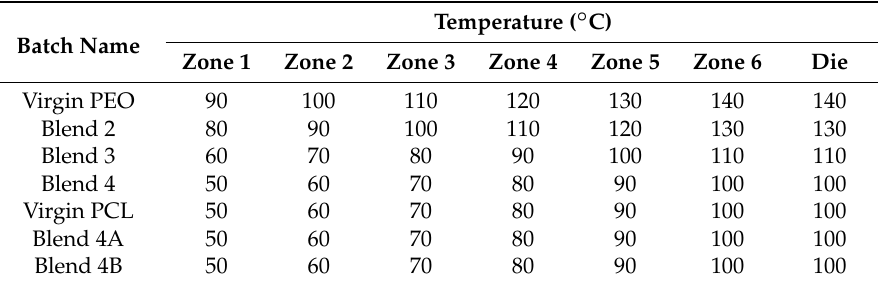
Table 2. Extrusion conditions of